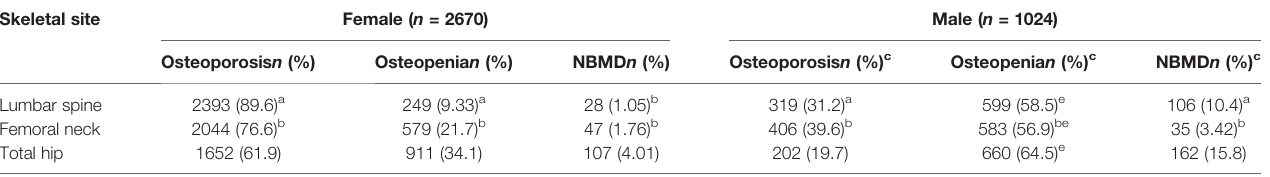
TABLE 2 | Number and rates of osteoporosis, osteopenia and normal BMD in fractures using gender speci fi c T -scores. Skeletal site